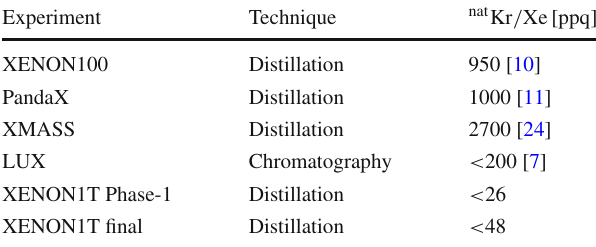
Table 2 Results on the krypton concentration measurements of differ- ent experiments